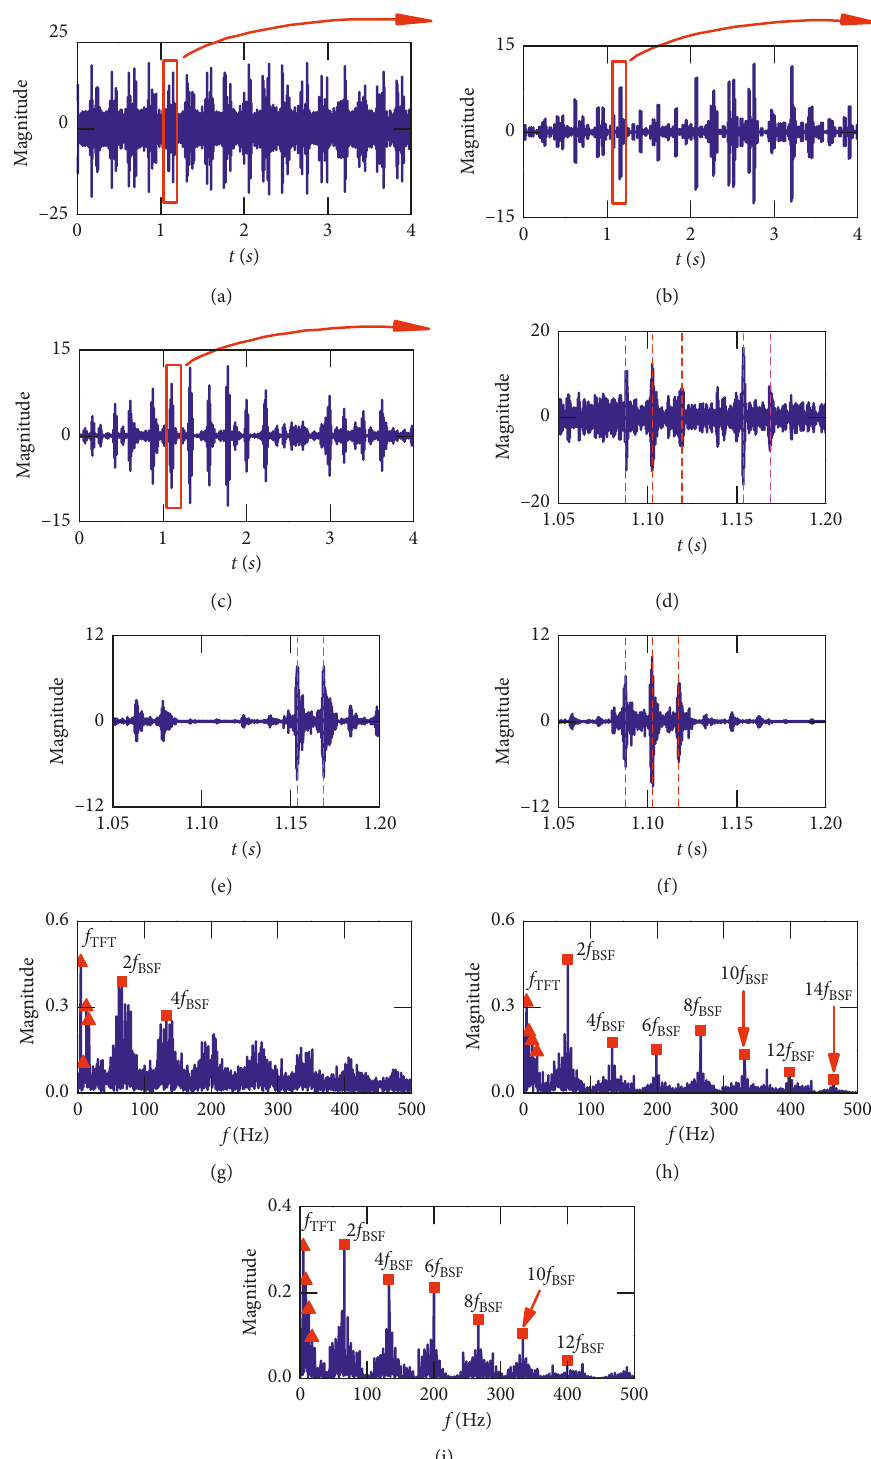
Figure 16: Results obtained by the proposed CPS for a bearing roller fault signal: (a) IMF 2; (b) first periodic impact component extracted from (a); (c) second periodic impact components extracted from (a); (d–f) locally zoomed figures of the waveforms shown in (a–c), respectively; (g–i) squared envelope spectra of (a–c),